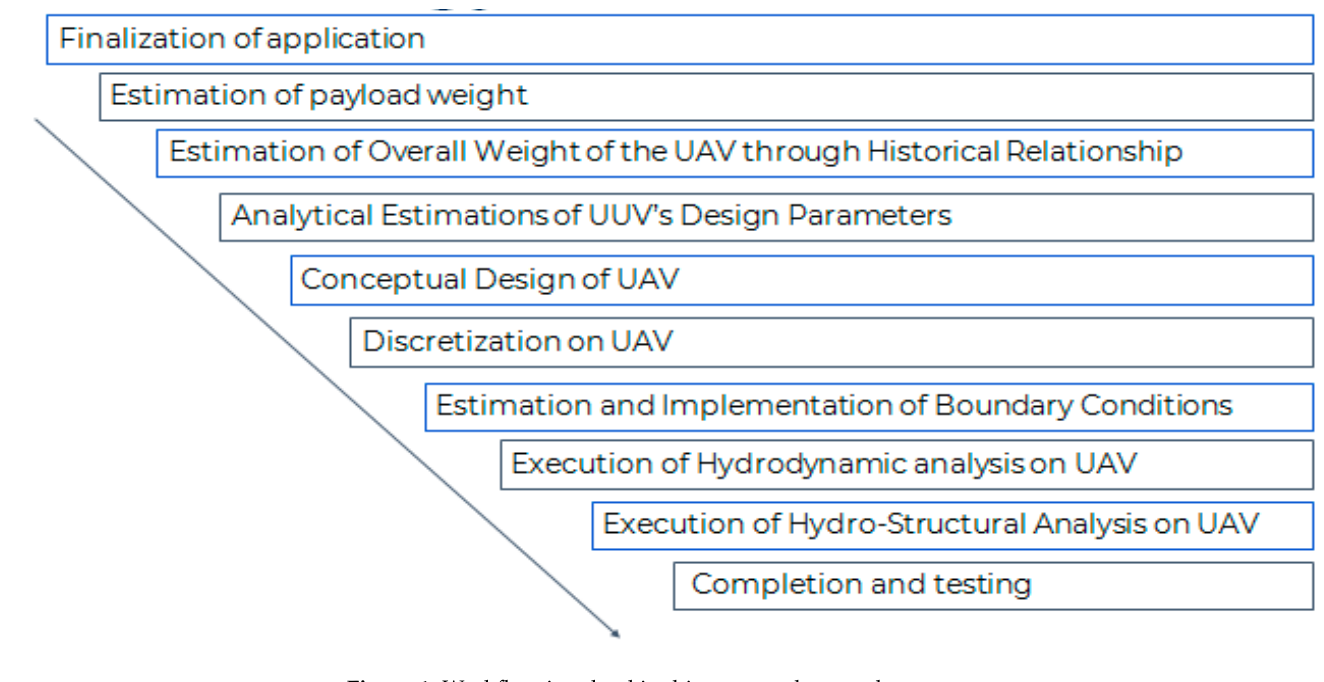
Figure 1. Workflow involved in this proposed research.